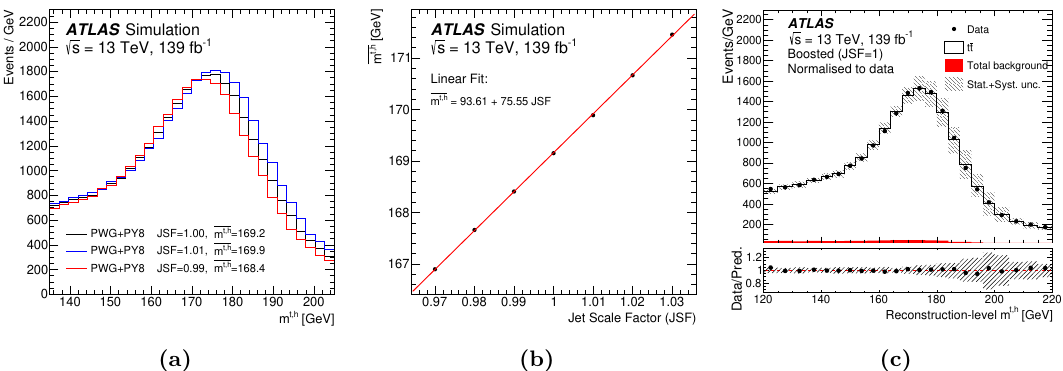
Figure 1. (a) The distribution of the invariant mass of the top-tagged jet ( m t,h ) for the ex- pected signal plus background for three example values of the JSF. PWG+PY8 corresponds to the Powheg+Pythia sample. (b) The mean of the same distribution ( m t,h ) as a function of JSF and a linear fit to the simulated samples. Uncertainties in the mean due to limited MC sample size are included for each point, but are too small to be visible. (c) The m t,h distribution observed in the data compared with the expected signal and background processes for JSF = 1 , where the expectation is normalised to the number of events observed in